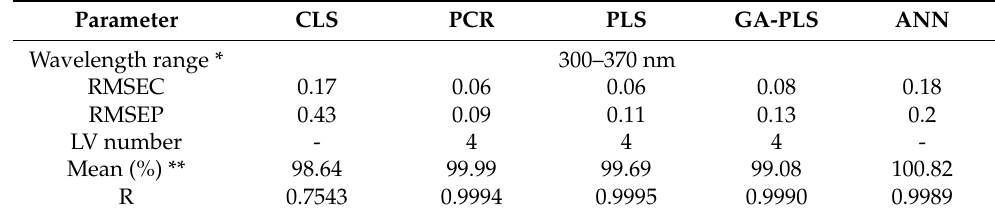
Table 2. The performance parameters of the five developed models for FVR